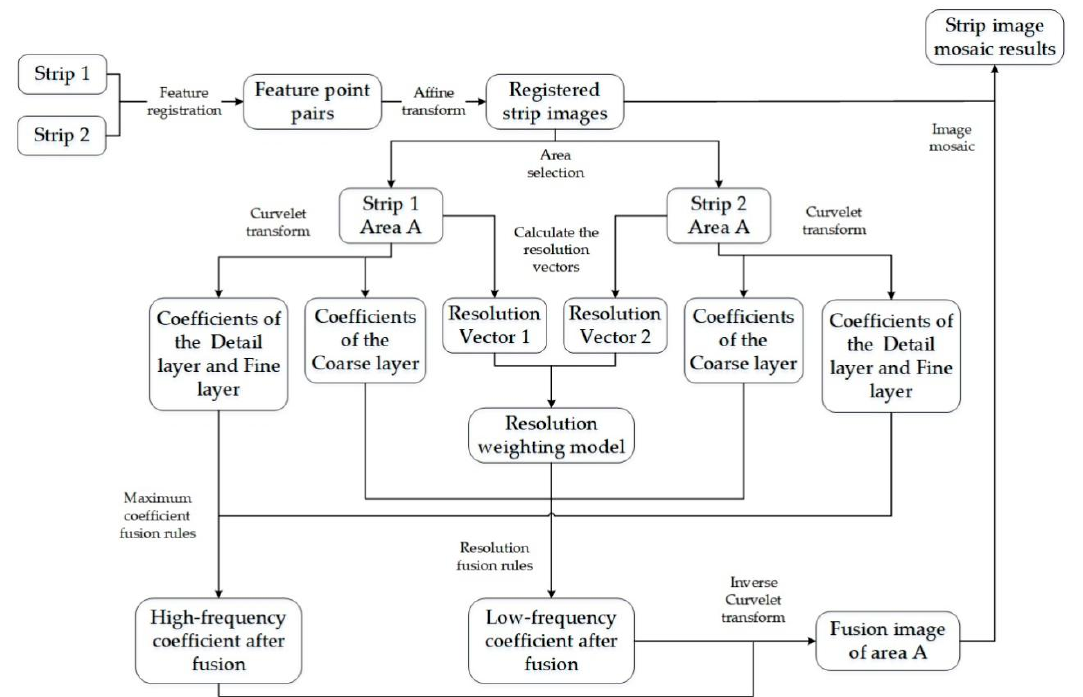
Figure 2. Flowchart of the proposed method.